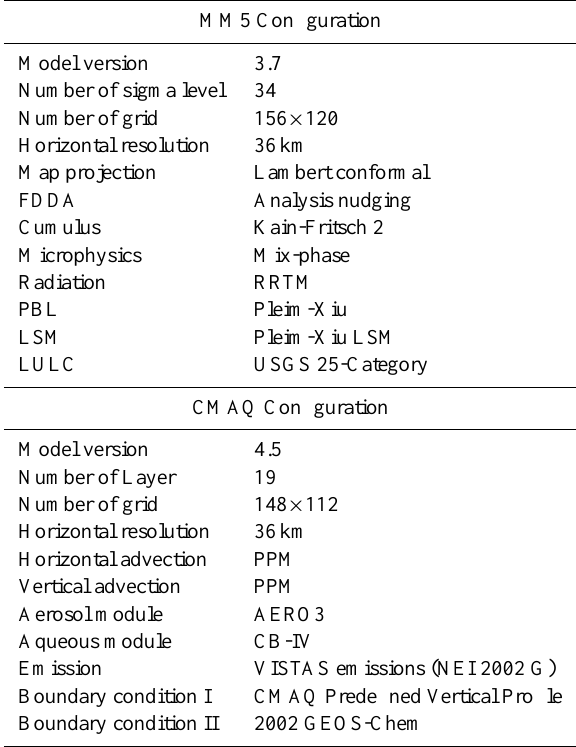
Table 1. MM5 and CMAQ Model Configurations for 2002 simula-